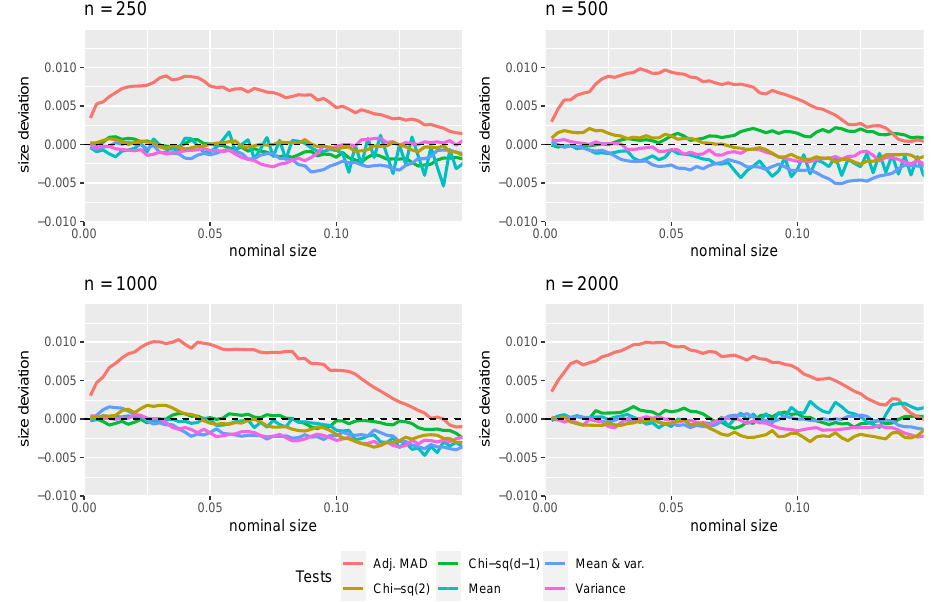
Figure 2. First digit tests: deviation of the actual size from the nominal size. Tests are as follows: “Adj. MAD”, adjusted MAD (10); “Chi-sq(2)”, χ 2 ( 2 ) test on mean and variance (4); “Chi-sq(d-1)”, χ 2 ( 8 ) test (9); “Mean”, normal test on the mean (1); “Mean & var.”, normal test on mean and variance (3); “Variance”, normal test on variance (2). The number of observations is indicated on top of each panel.